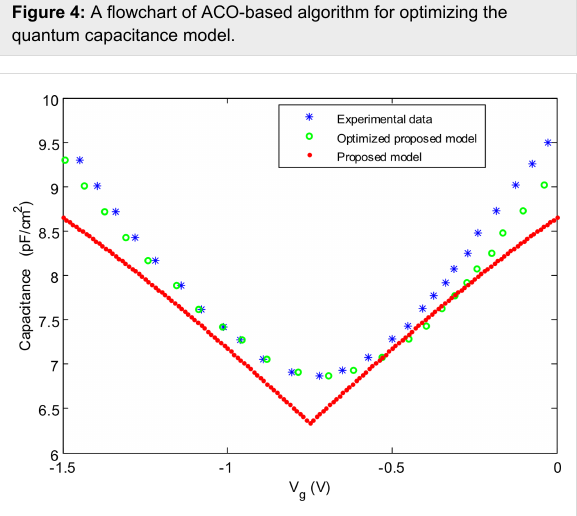
Figure 5: Comparison between the proposed single-layer graphene quantum capacitance model, the optimized proposed model and the experimental extracted